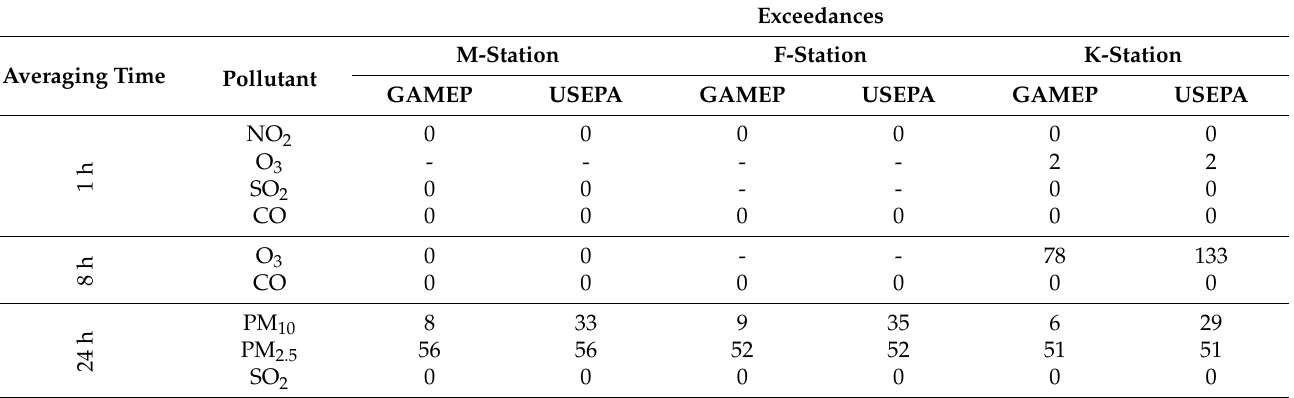
Table 2. Air pollutant exceedances with reference to GAMEP and USEPA standards during the lockdown period at the three studied sites (residential (M), traffic (F), and work